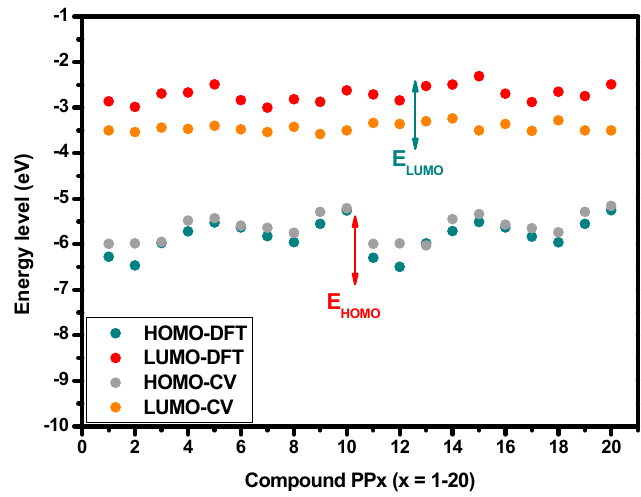
Figure 12. Comparison of frontier orbitals’ energy levels obtained from cyclic voltammetry and DFT calculations.